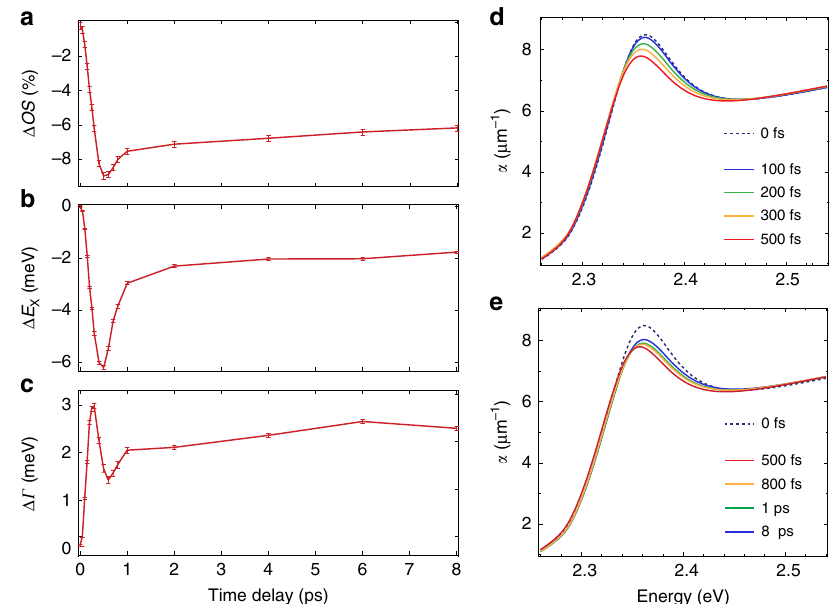
Fig. 3 Re fl ectivity lineshape analysis. a – c Temporal evolution of the oscillator strength ( Δ OS , a ), peak position ( Δ E x , b ) and linewidth ( Δ Γ , c ), obtained through the fi t of Δ R ∕ R ( ω , t ) at the excitation density of n = 5 × 10 18 cm − 3 . d , e Evolution of the absorption spectra α ( ω , t ) of CH 3 NH 3 PbBr 3 single crystals in the vicinity of the excitonic resonance as calculated with the Tauc-Lorentz fi t of Δ R ∕ R ( ω , t ) in the temporal windows ( d ) from 0 fs to 500fs and ( e ) from 500fs to 8ps.